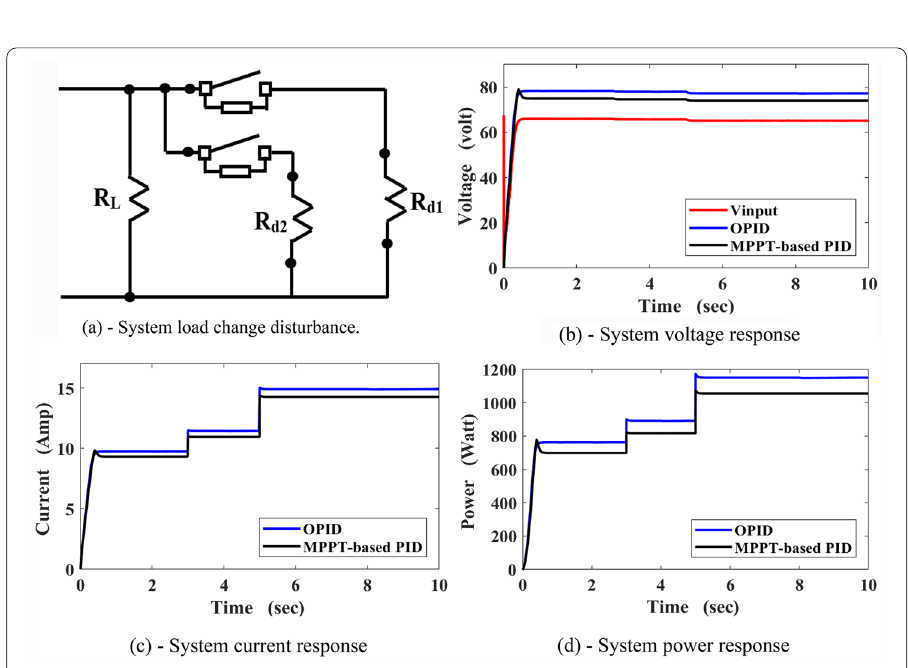
Fig. 14 The system responses associated with the system running under load change